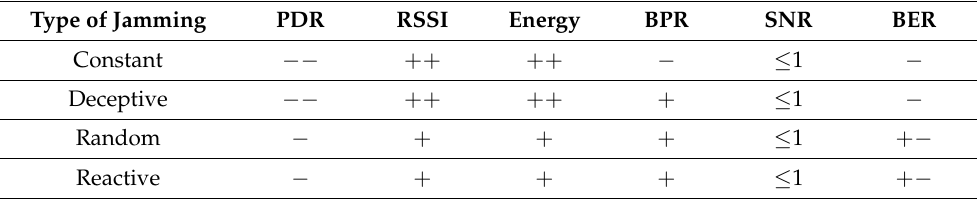
Table 3. Jamming symptoms